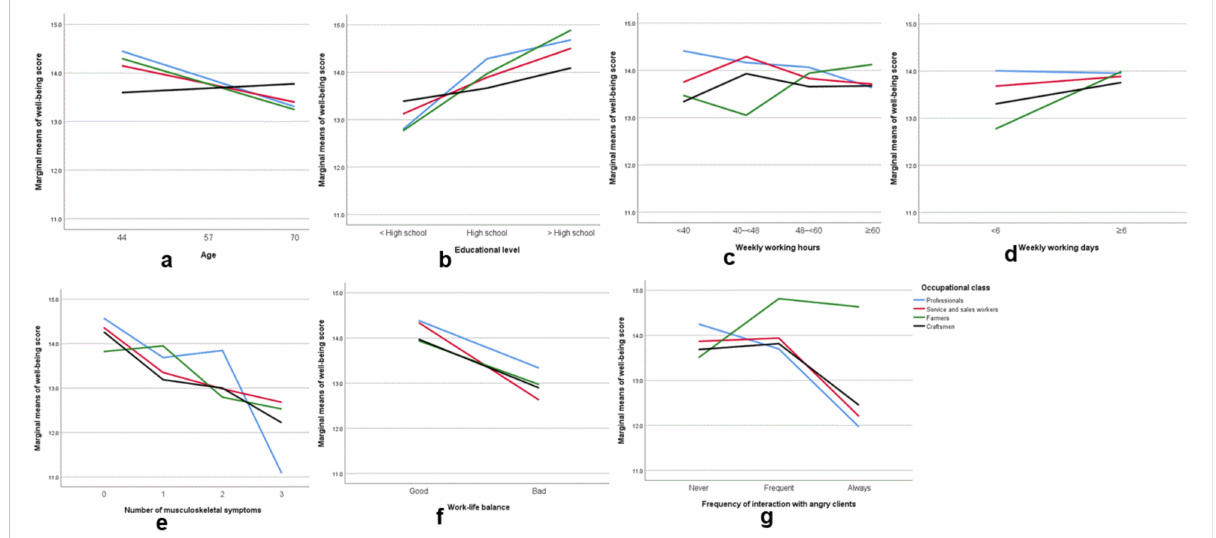
Figure 1. ( a – g ). Interaction between independent variables and occupational class in their influence on psychological well-being: ( a ) age; ( b ) educational level; ( c ) weekly working hours; ( d ) weekly working days; ( e ) number of musculoskeletal symptoms; ( f ) work–life balance; ( g ) frequency of interaction with angry